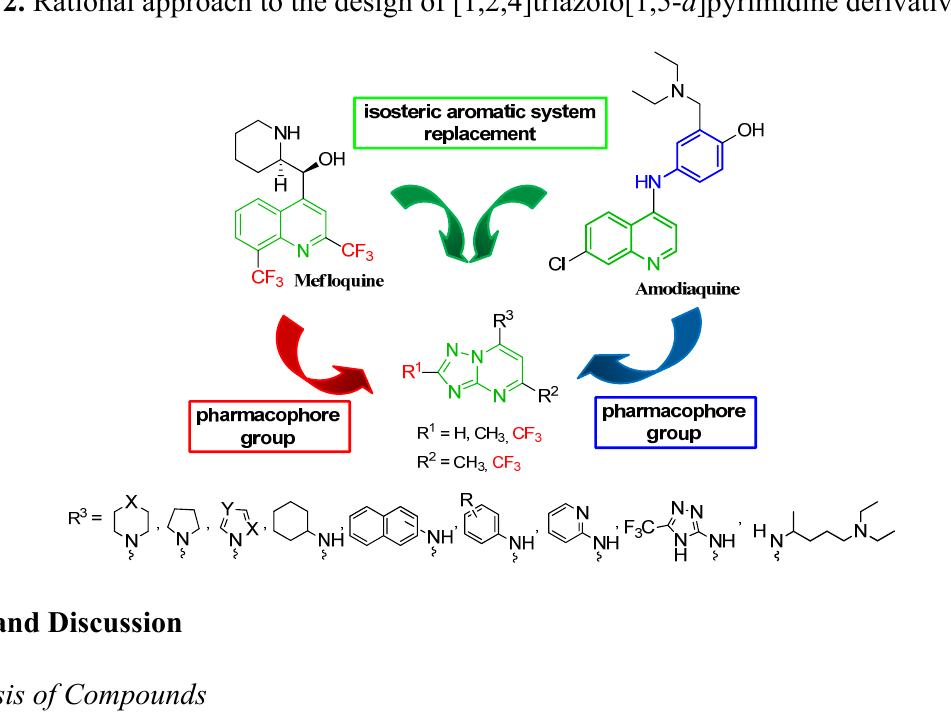
Figure 2. Rational approach to the design of [1,2,4]triazolo[1,5- a ]pyrimidine derivatives 4 – 29